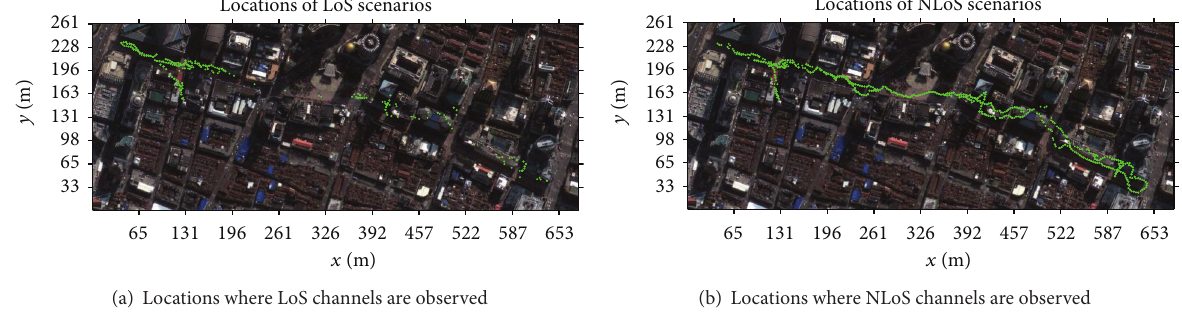
Figure 5: The locations where the channels are found to be LoS and NLoS channels along the Nanjing Road.